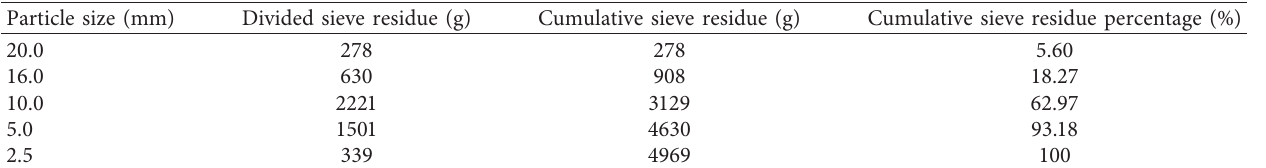
Table 4: Recycled coarse aggregate